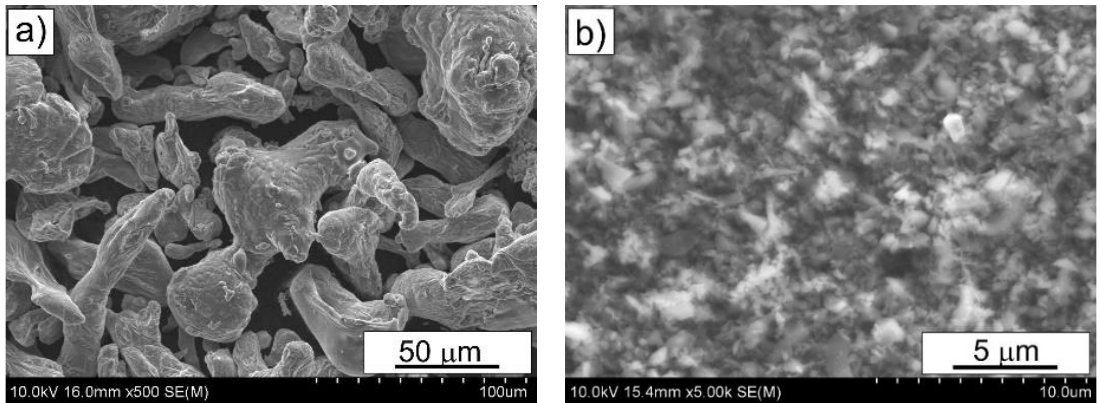
Figure 1. Morphology of initial powders: ( a ) Alumix 431 and ( b ) B 4 C. The relative density of the composites was measured by the Archimedes’